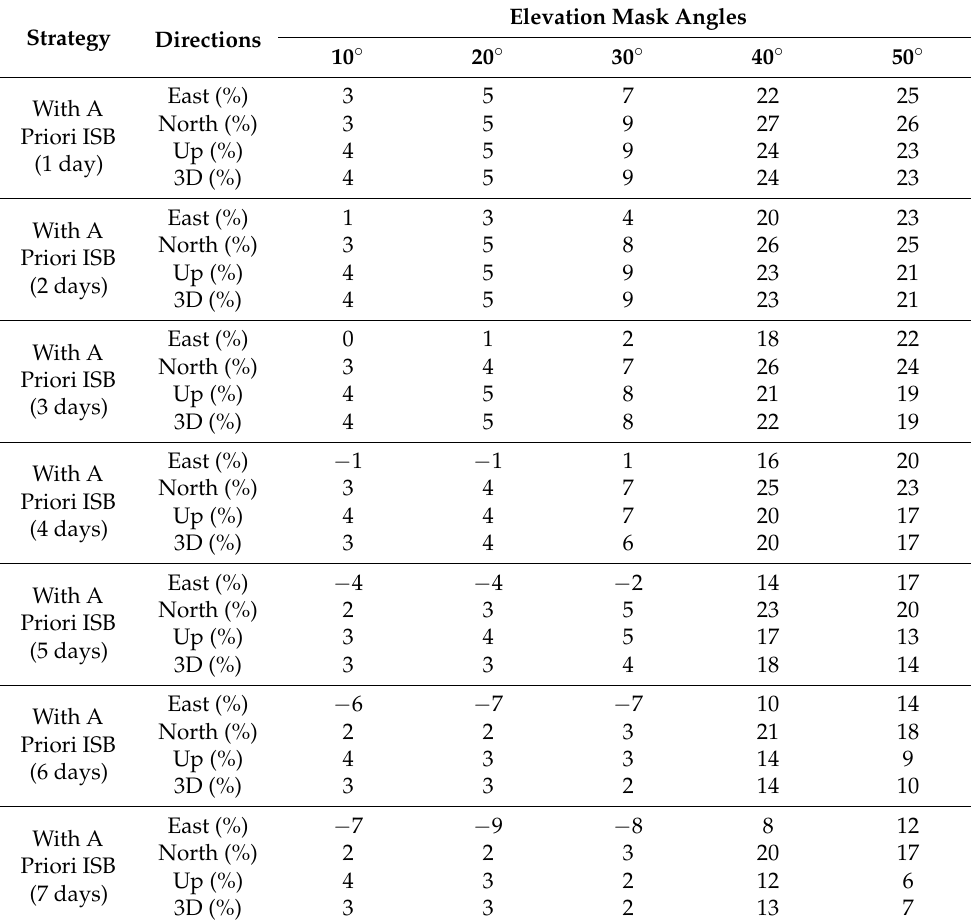
Table 5. Improvement rates of positioning accuracy in (m) for the seven four-system SPP cases considering a priori ISB constraints over the one ignoring a priori ISB constraints under different elevation